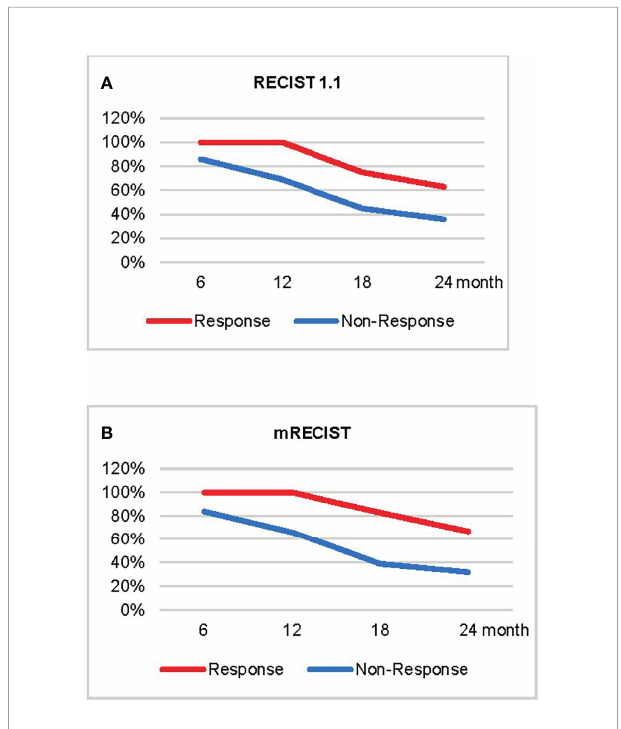
evaluation criteria (RECIST 1.1) and immune-related criteria (iRECIST and mRECIST), have been reported to assess the ef fi cacy of immunotherapy. However, it is unclear which criteria are best for evaluating immune-related response. In addition, the